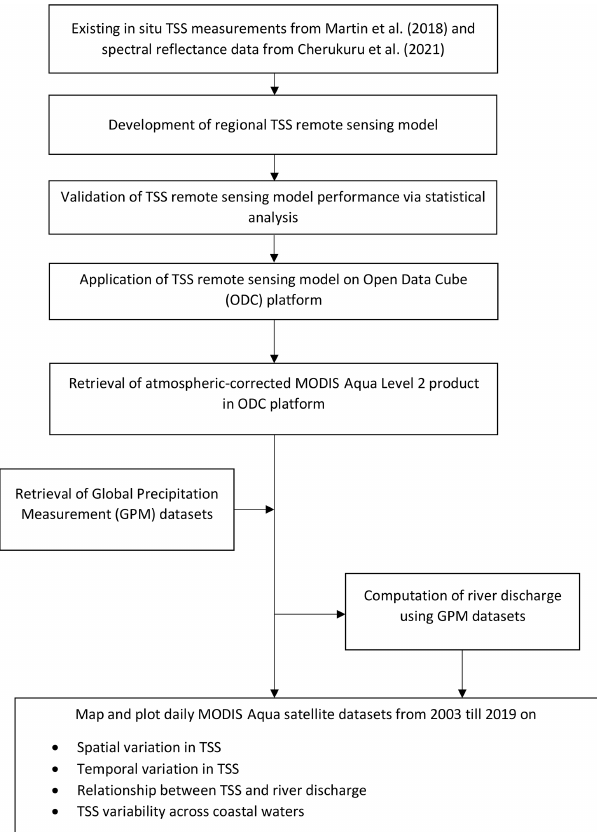
Figure 1. Flowchart summarizing the processes of developing a regional TSS remote sensing model and applying it to analyse the spatial and temporal variation in TSSs over the study region, using MODIS Aqua data from year 2003 until 2019. Long-term MODIS Aqua datasets were analysed and mapped on an Open Data Cube (ODC) platform with implementation of robust Python li- braries and